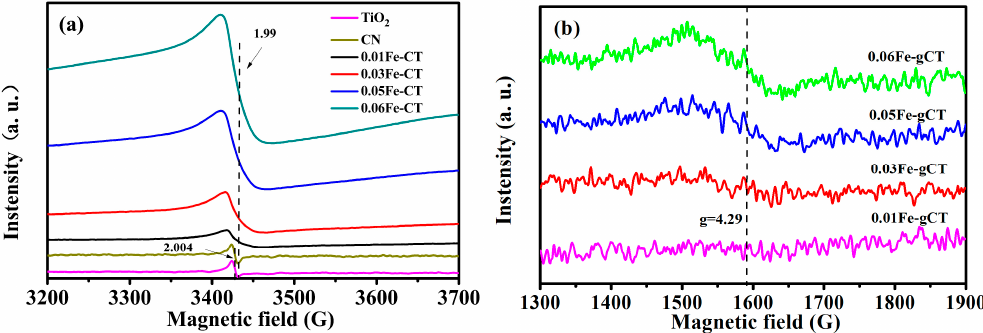
Figure 5. EPR spectra of different test field ( a , b ) of TiO 2 , 0.01Fe ‐ CT, 0.03Fe ‐ CT, 0.05Fe ‐ CT, and 0.06Fe ‐ CT.